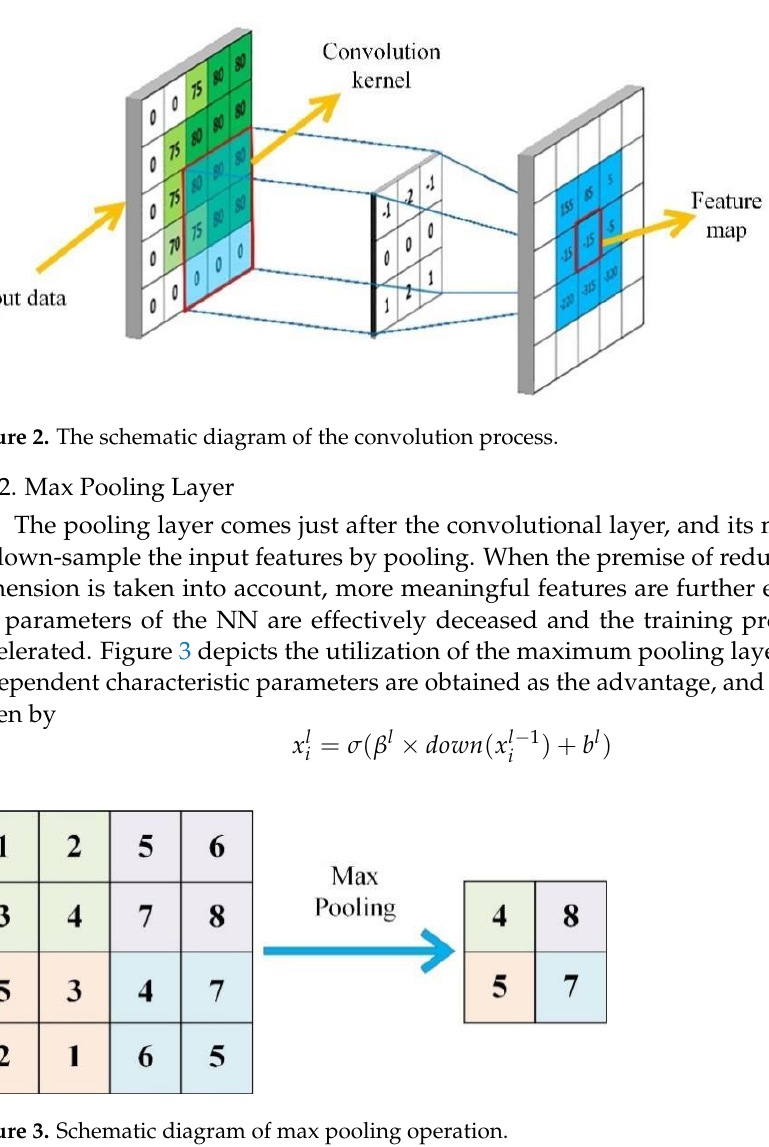
Figure 3. Schematic diagram of max pooling operation.